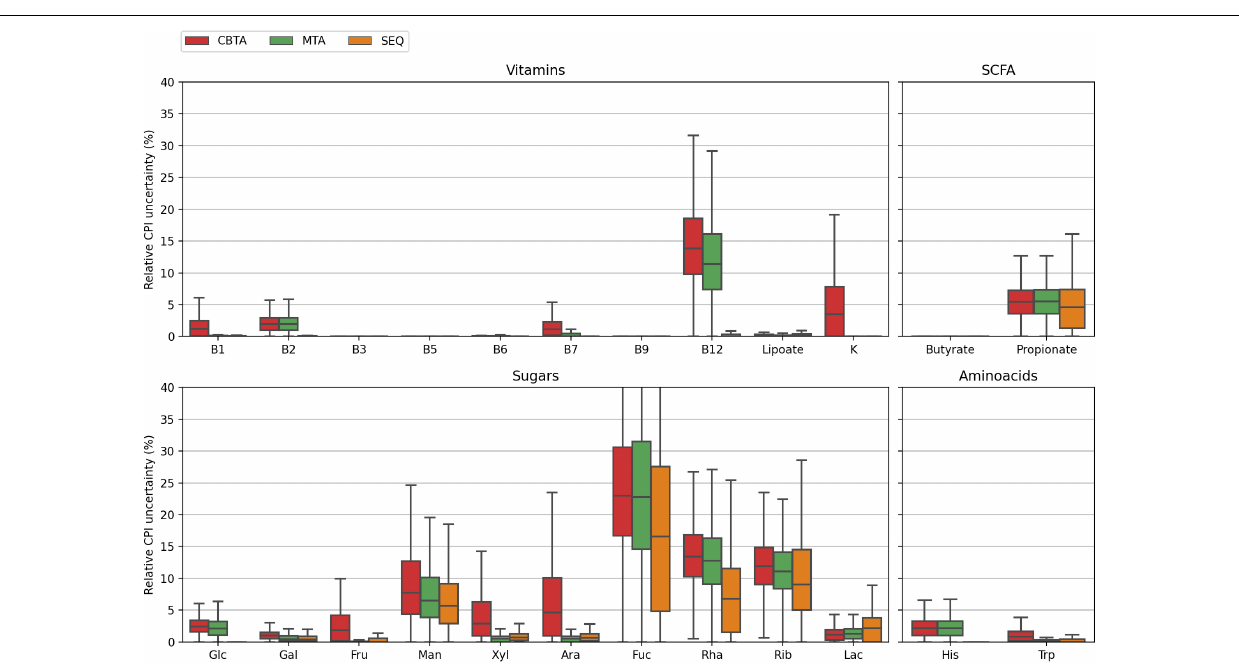
Frontiers in Microbiology |